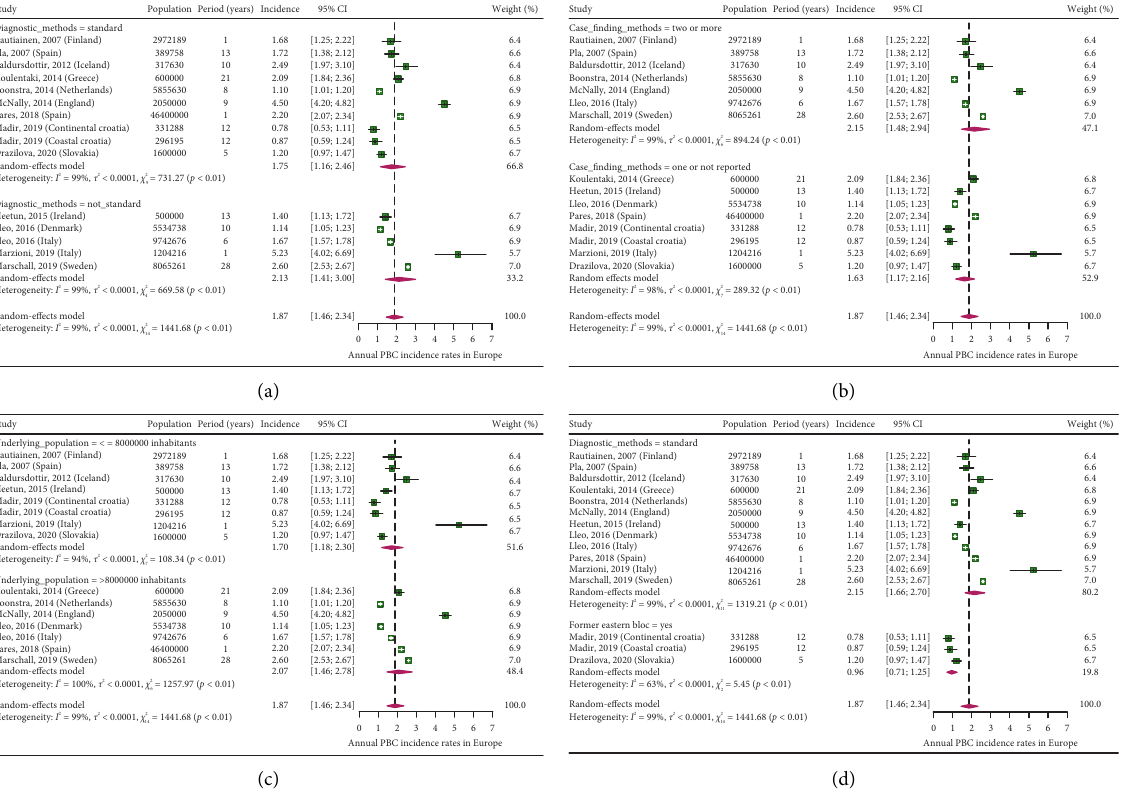
Figure 10: Subgroup analyses of annual PBC incidence rates. (a) Diagnostic criteria. (b) Case-finding methods. (c) Underlying population. (d) Former Eastern/Western